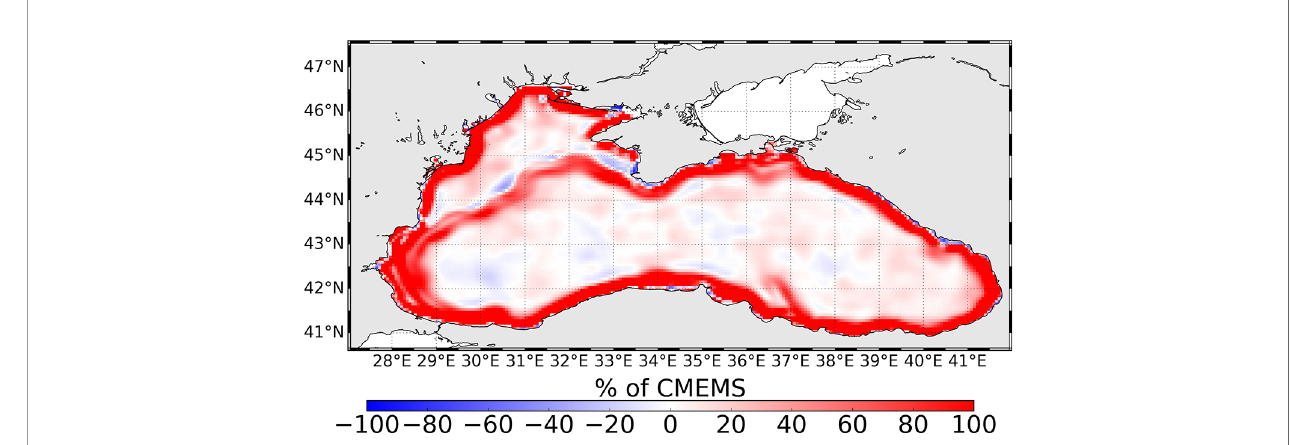
FIGURE 2 | Relative differences in mean eddy kinetic energy obtained from EO4SIBS-ADT and CMEMS-ADT